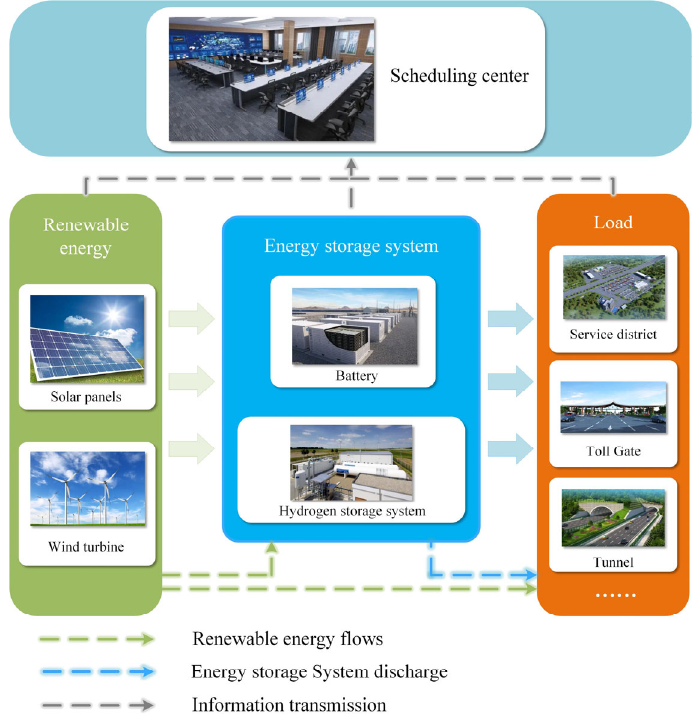
Figure 1. Highway Self ‐ Consistent Energy System structure.